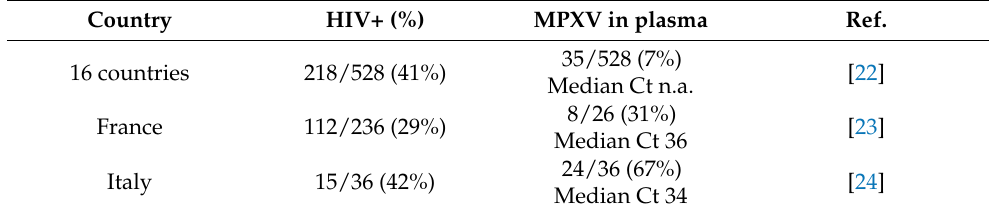
Table 1. MPXV DNA prevalence (%) and median cycle thresholds (Ct) in registry studies during the 2022